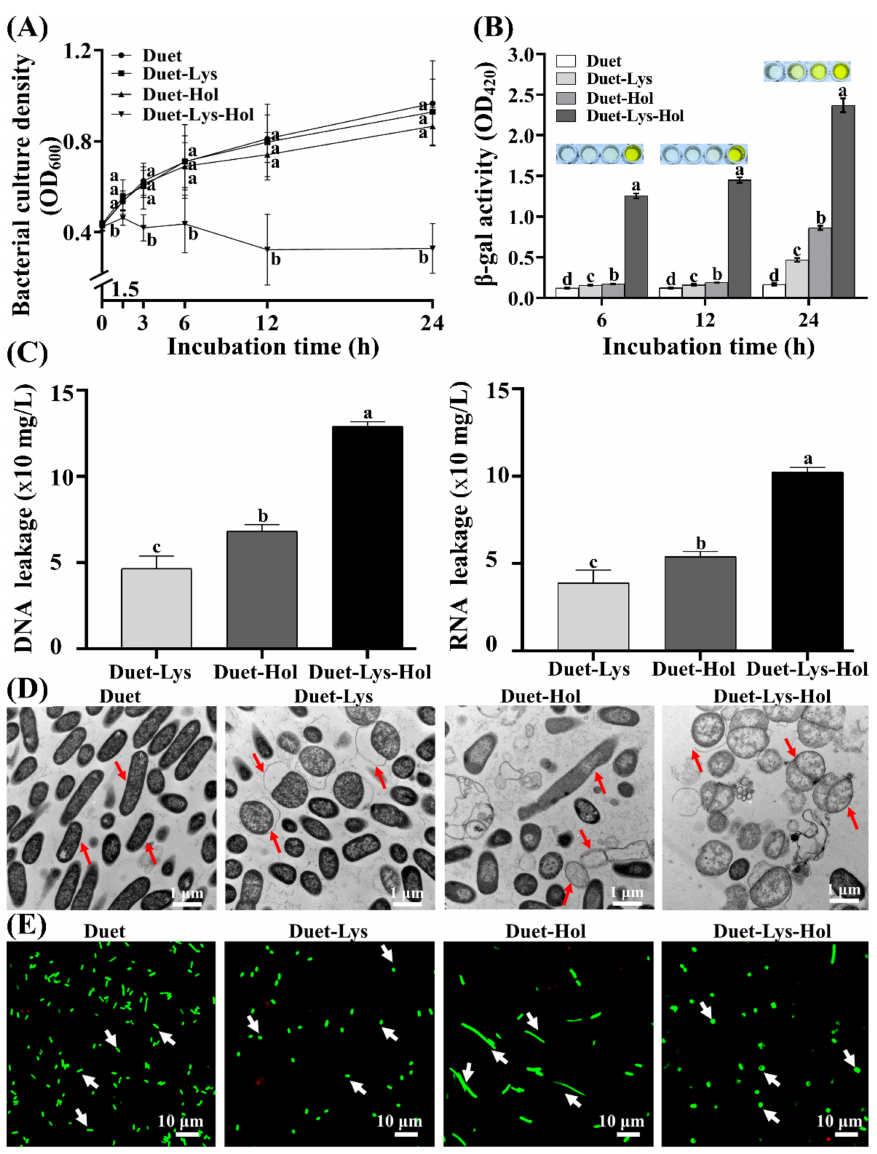
Figure 8. Co-expression of X2-Lys and X2-Hol and its effect on bacterial growth and cell membrane integrity. ( A ) Bacterial growth ( n = 9). Different lowercase letters represent significant difference ( p < 0.05) in bacterial culture density among the four groups of Duet, Duet-Lys, Duet-Hol and Duet- Lys-Hol at the same time point. ( B ) β -galactosidase activity (OD 420 ) after 6, 12 and 24 h of induction. Different lowercase letters above each bar represent significant difference ( p < 0.05) in β -galactosidase activity among the four groups of Duet, Duet-Lys, Duet-Hol and Duet-Lys-Hol at the same time point. ( C ) The release of DNA/RNA after 24 h of induction ( n = 5). Different lowercase letters above each bar represent significant difference ( p < 0.05) in RNA or DNA leakage among the three groups of Duet-Lys, Duet-Hol and Duet-Lys-Hol. ( D ) Transmission electron microscopic observation after 12 h of induction. ( E ) Fluorescence microscopic observation after 12 h of induction. Duet, empty plasmid; Duet-Lys, Duet carrying X2-Lys; Duet-Hol, Duet carrying X2-Hol; Duet-Lys-Hol, Duet carrying X2-Lys and